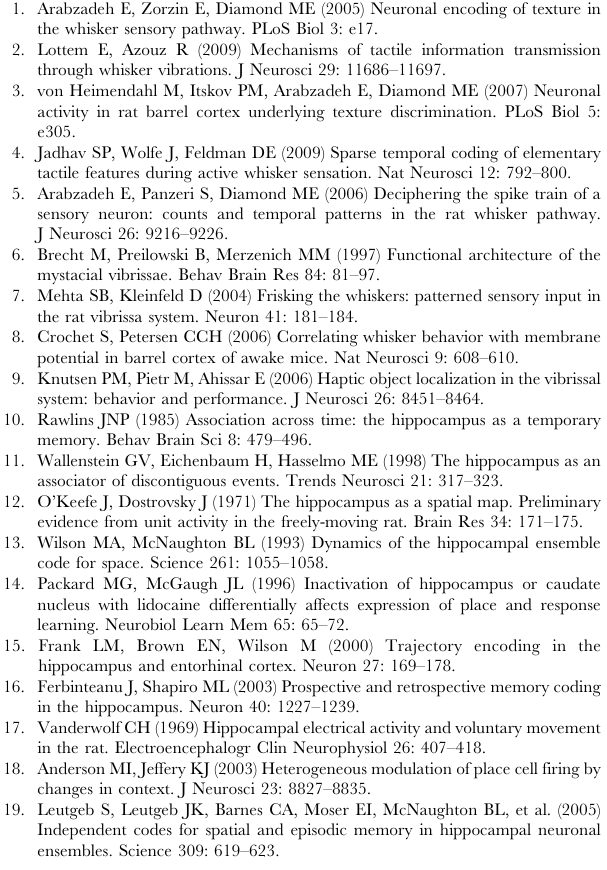
Figure S10 Tactile stimuli. Photographs of rough tactile discrimanda, textures 2–4 (T2–T4). T1 was a smooth plate. Scale bar is 10